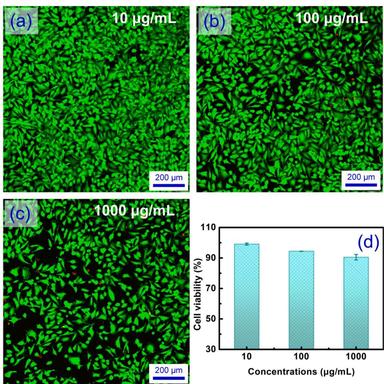
LIVE/DEAD cell viability assay: in vitro cell morphologies of GES-1 cells after 72 h of incubation with (a) 10, (b) 100, and (c) 1000 μg/mL SCB–Ben/SA extracts. (d) CCK-8 assay: cell viabilities after contact with different concentrations of SCB–Ben/SA extracts.